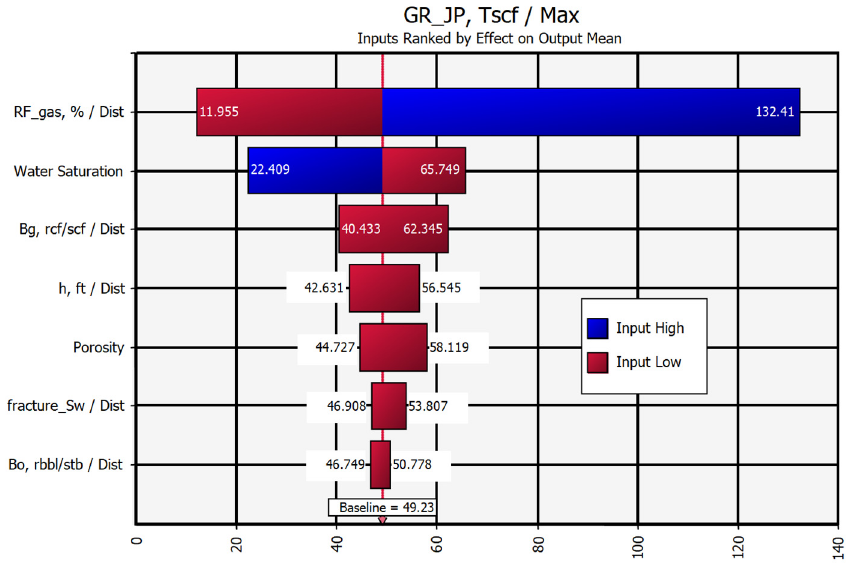
Figure 11. Tornado chart of Scenario 1, which is a base case (see Figure 12).